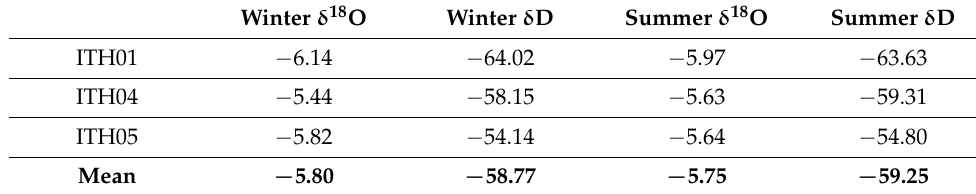
Table 2. The mean δ 18 O and δ D values for winter and summer for thermal water.